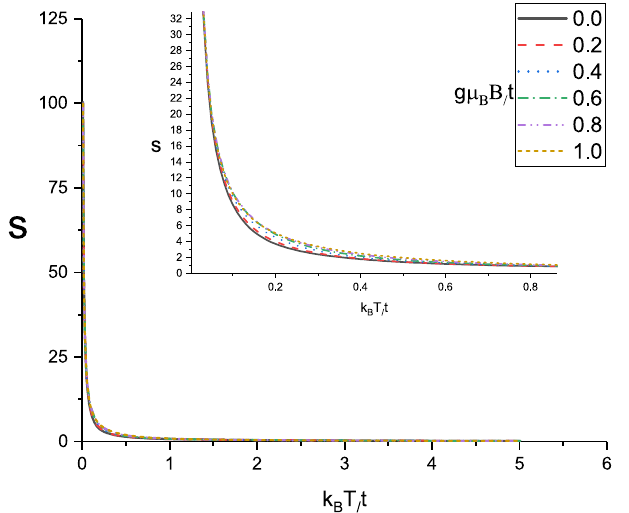
Figure 10. Seebeck coefficient of Lieb lattice as a function of normalized temperature k B T / t for different values of normalized magnetic field g µ B B / t at fixed gap parameter �/ t = 0.3 . Normalized chemical potential and normalized spin-orbit coupling strength have been fixed at µ/ t = 1.0 and (cid:31) / t = 0.2 ,